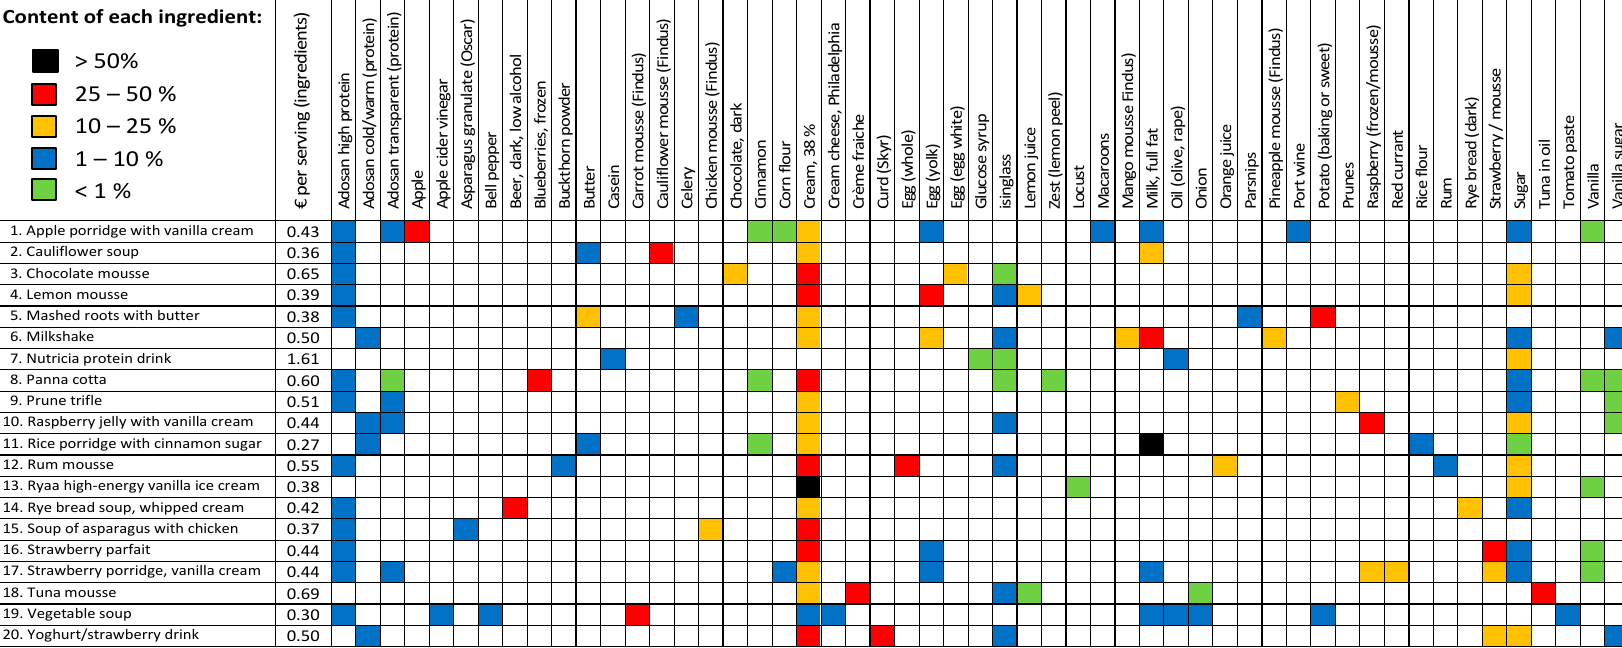
Content of each ingredient: